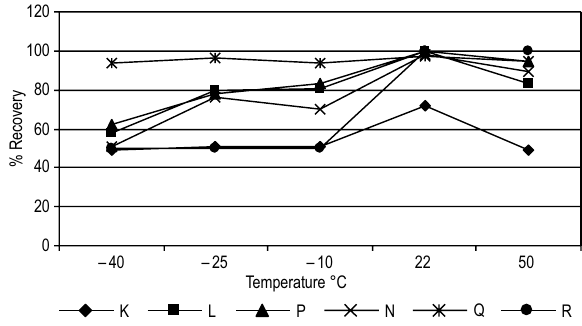
Fig. 4. Mode of recovery of various preformed seals from –40 °C to